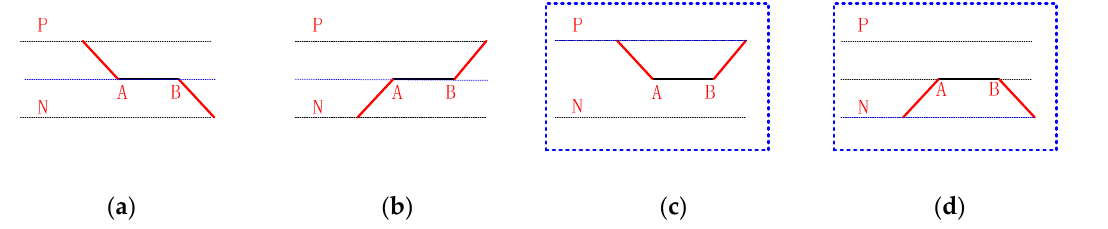
Figure 6. Four modes of H4 topology under USPWM. ( a ) PC mode; ( b ) NC mode; ( c ) PF mode; ( d ) NF mode.